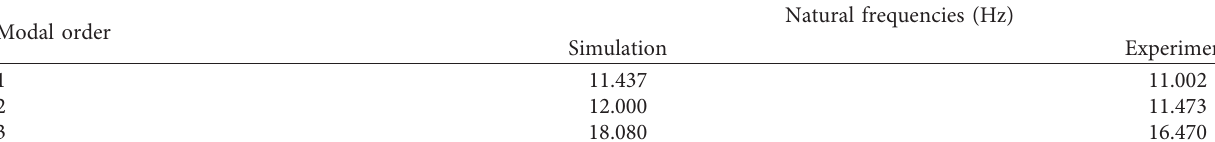
Table 2: Natural frequencies of experiments and simulations.